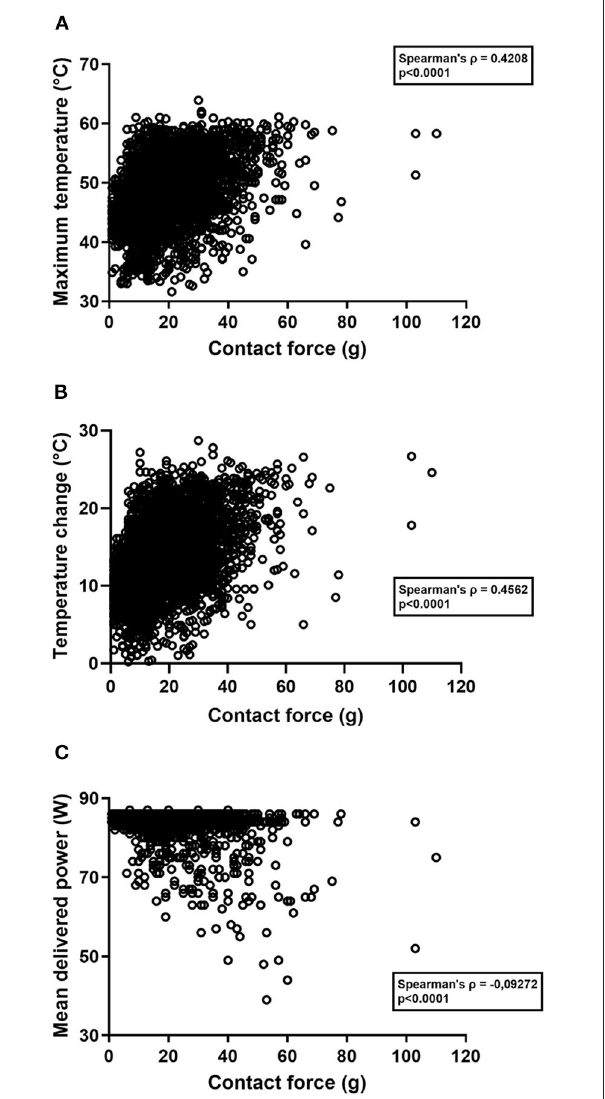
FIGURE 4 | (A–C) Scatter plot diagrams of the correlations between different parameters registered during radiofrequency applications. (A) Correlation between contact force and the maximum temperature. (B) Correlation between contact force and temperature change. (C) Correlation between contact force and the mean delivered power. ρ , correlation